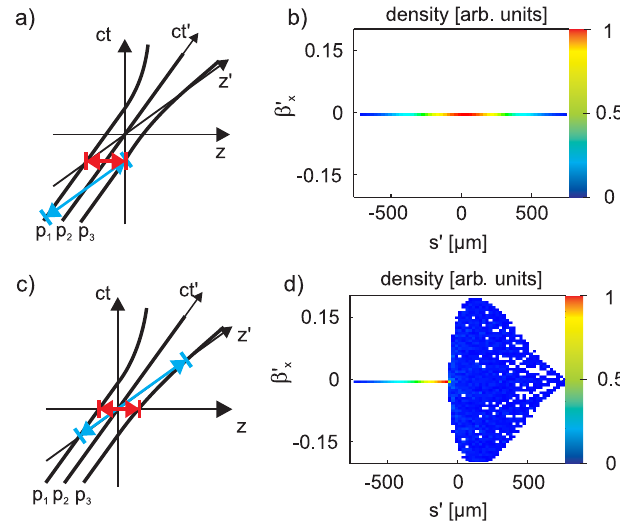
FIG. 1. (Color) The electron bunch is shown schematically in (a) at the end of the wakefield acceleration in its initial configu- ration using a Minkowski diagram in the laboratory frame (red) and the mean rest frame (blue). The spatial axis z is the longitudinal propagation direction. The plasma boundary is located in the laboratory frame at z ¼ 0 and in the mean rest frame at z 0 ¼ 0 . p 1 , p 2 , and p 3 are 4D trajectories corresponding to the rear end, the center, and the front end of the bunch. Part (b) shows the beam state using a PPI simulation performed in the mean rest frame in correspondence with (a). The longitudinal bunch position s 0 is plotted against the normalized transverse velocity (cid:6) 0 x with s 0 ¼ 0 being the center of mass. Part (c) shows the situation when half of the particles have left the plasma and (d) correspondingly in the mean rest frame at t 0 ¼ 0